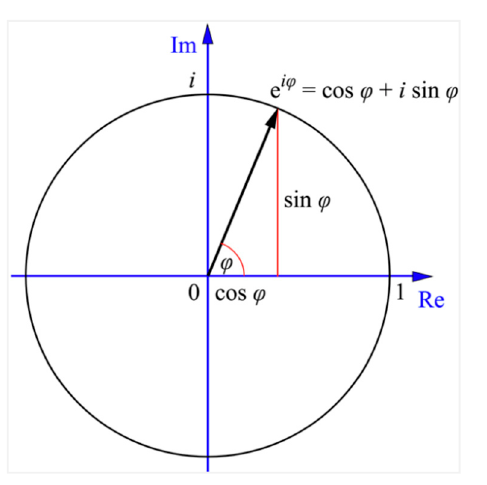
Figure 9. Euler’s formula .